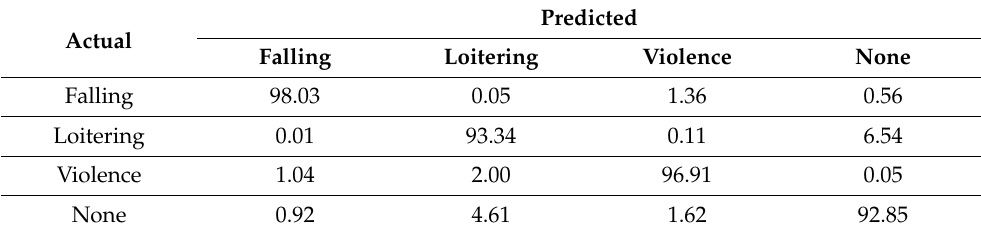
Table 5. Confusion Matrix (%) for the proposed approach.